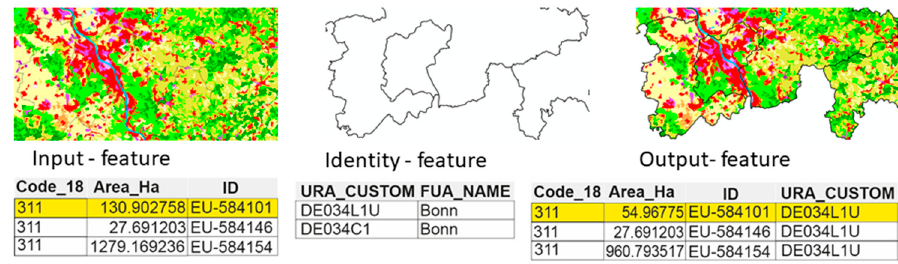
Figure 3. Identity tool in ArcGIS .